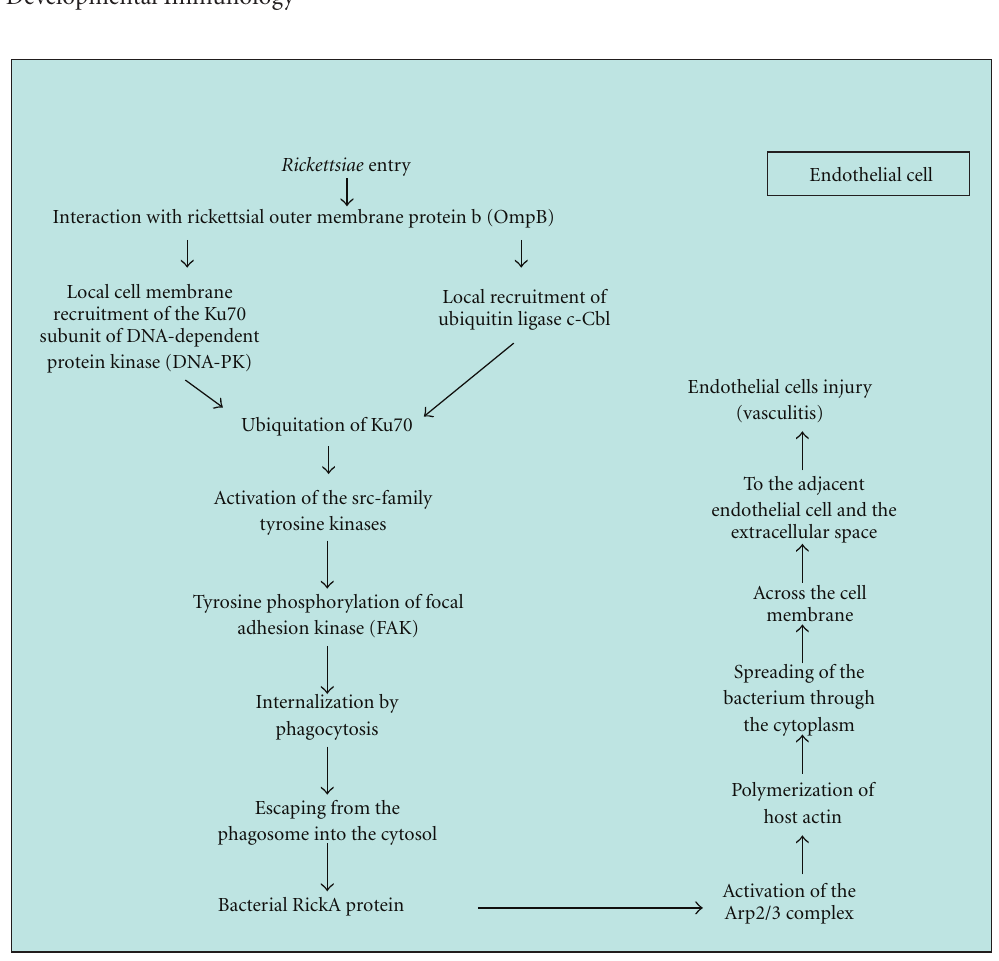
Figure 1: Rickettsia entry into endothelial